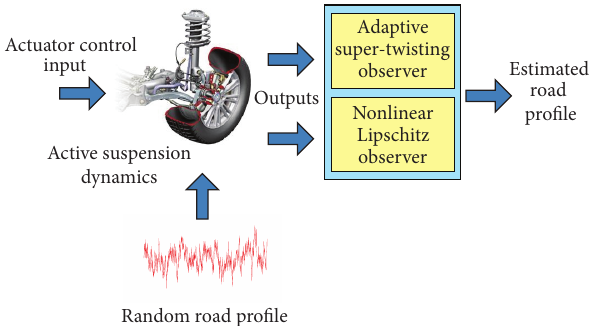
Figure 2: Overview of proposed